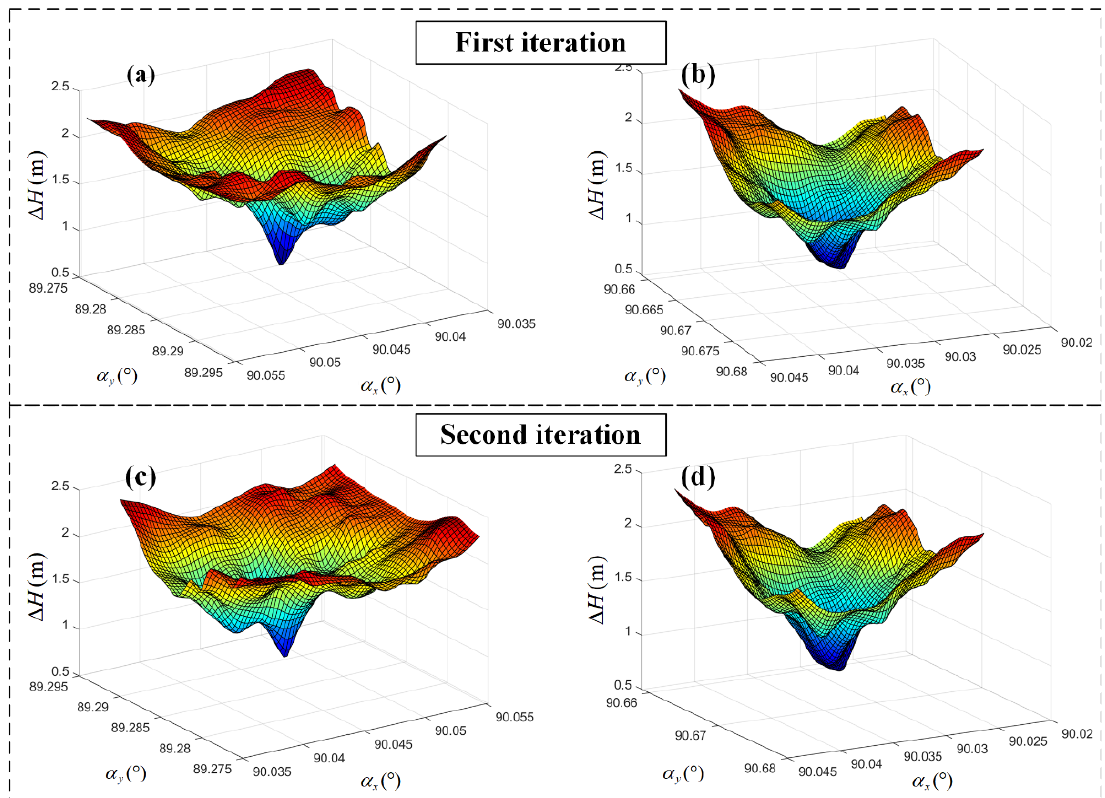
Figure 9. The laser grid pointing angle and the sum of the elevation residual plots after calibration based on LiDAR data. ( a , b ) are the experimental results of beams 1 and 2 after the first iteration, respectively.( c , d ) are the experimental results of beams 1 and 2 after the second iteration,